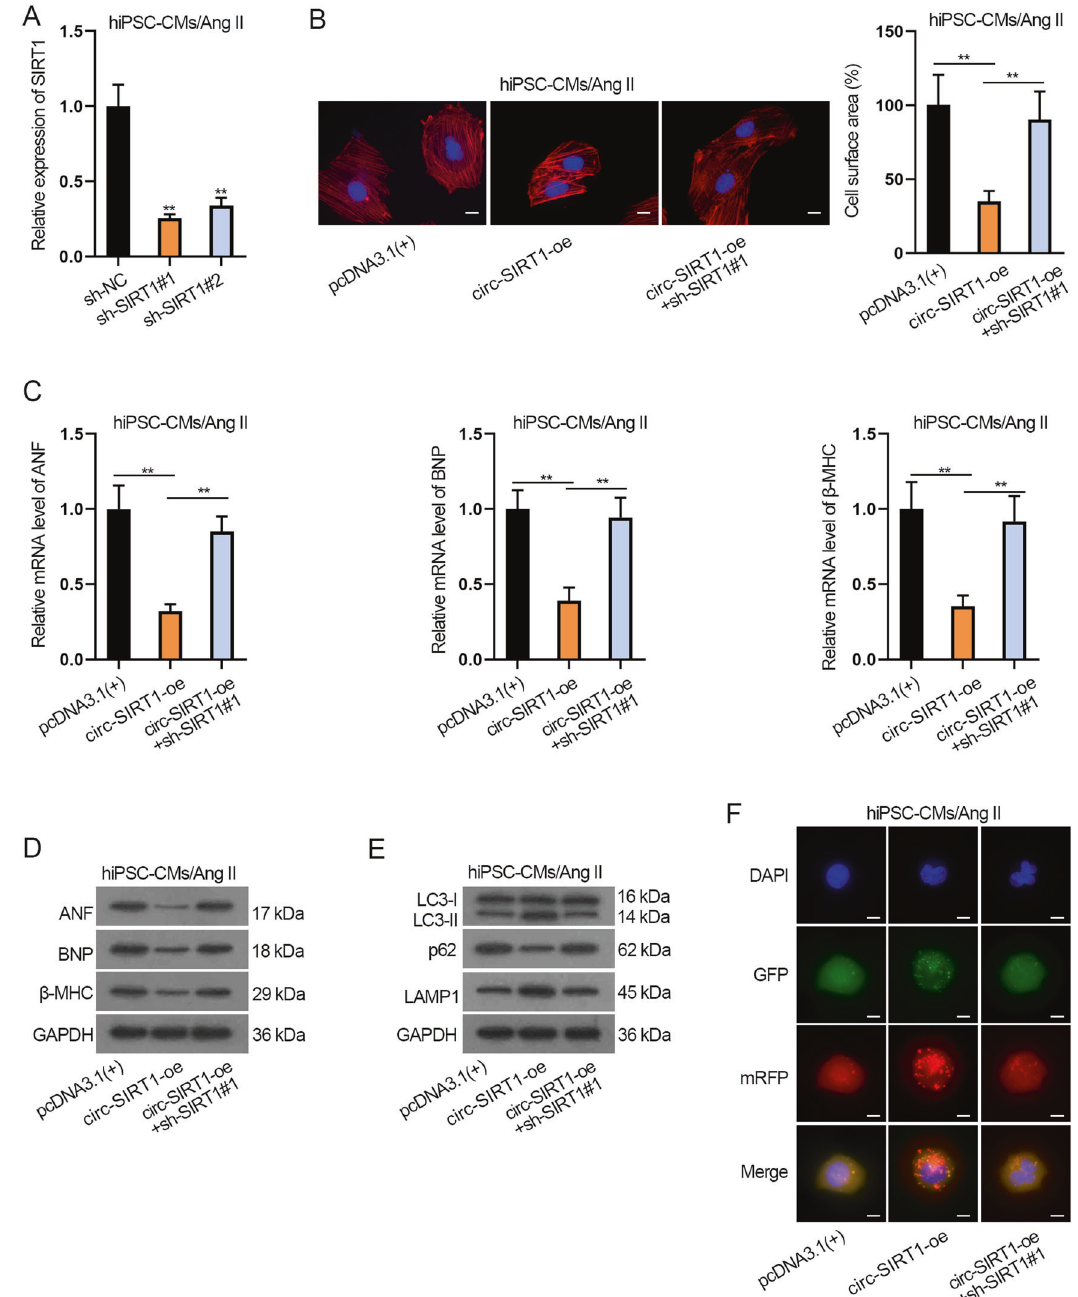
Fig. 6 Circ-SIRT1 inhibits CH via upregulating SIRT1 to enhance autophagy. A The knockdown ef fi ciency of SIRT1 in Ang II-infused hiPSC- CMs was evaluated via RT-qPCR. N = 3. B Immuno fl uorescence staining analysis of the cell surface area after Ang II-infused hiPSC-CMs were transfected with pcDNDA3.1( + ), circ-SIRT1-oe, or circ-SIRT1-oe + sh-circ-SIRT1#1. Scale bar, 10 μ m. N = 3. C , D RT-qPCR and western blot analyses of the expression of CH markers after Ang II-infused hiPSC-CMs were transfected with pcDNDA3.1( + ), circ-SIRT1-oe, or circ-SIRT1-oe + sh-circ-SIRT1#1. N = 3. E , F Autophagy in Ang II-infused hiPSC-CMs of the above-mentioned groups was measured by western blot analysis of autophagy-related proteins and immuno fl uorescence staining analysis of Ad-GFP-mRFP-LC3. Representative images of fl uorescent GFP dots (green), mRFP dots (red), and their merged images are shown. Scale bar, 10 μ m. N = 3. ** P < 0.01 was assessed by one-way ANOVA and